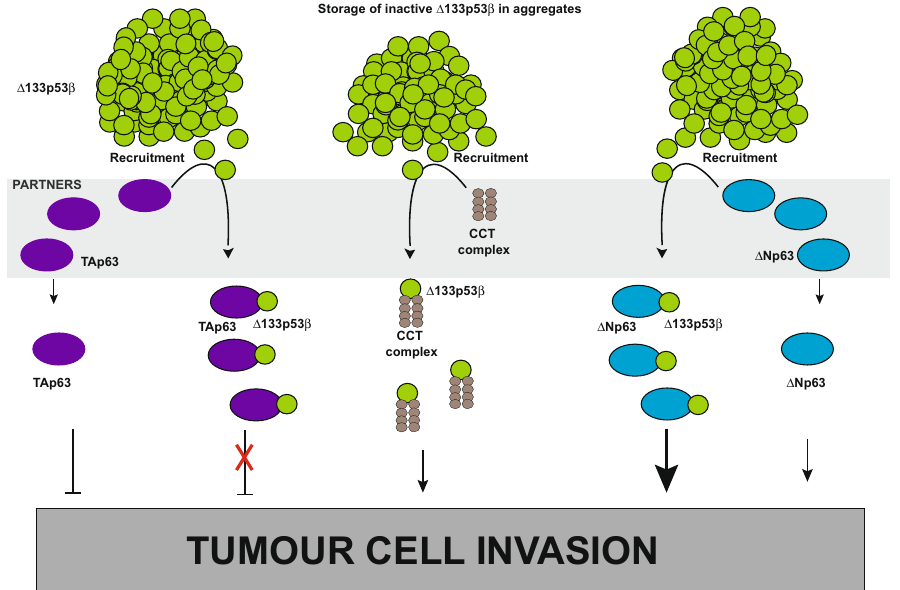
Fig. 7 Schematic representation of the Δ 133p53 β activity regulation through aggregation. Increased expression of Δ 133p53 β in cancer cells leads to its accumulation and creation of the aggregates. Δ 133p53 β can form stable aggregates mostly due to its unfolded conformation. Δ 133p53 β sequestration in aggregates would store isoform in inactive form. When this isoform activity is required, recruiting partners release it from aggregates. Recruiting partners are chaperones like CCT complex or p53 family members like p63 isoforms. The presence of recruiting partners increases cancer cell invasion. Interaction with CCT complex activates Δ 133p53 β driven invasiveness. The binding of Δ 133p53 β to p63 isoforms further leads to positive effects on invasion, either by synergizing the pro-invasive Δ Np63 isoforms activity or inhibiting the anti-invasive effect of TAp63